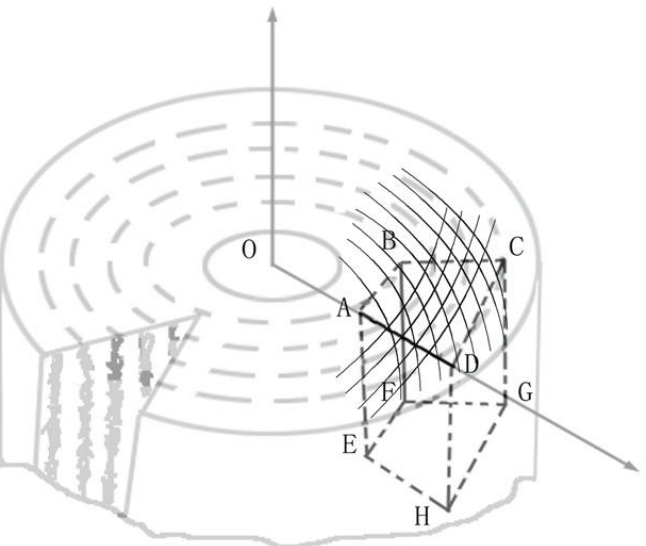
Figure 4. Schematic diagram of the sample acquired from the ivory or mammoth ivory. ABCD: transverse plane, CDHG: outer circumferential plane, ADHE: radial plane.